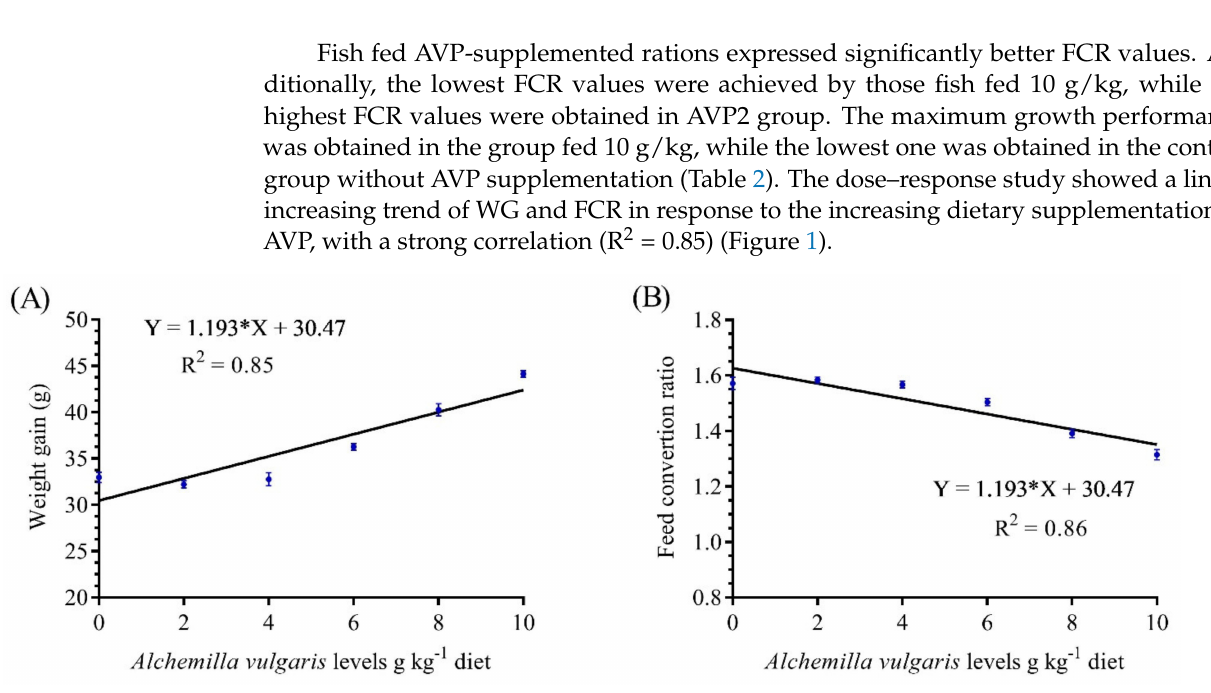
Figure 1. Fit linear regression models of weight gain ( A ) and feed conversion ratio ( B ) in response to increasing dietary supplementation of Alchemilla vulgaris